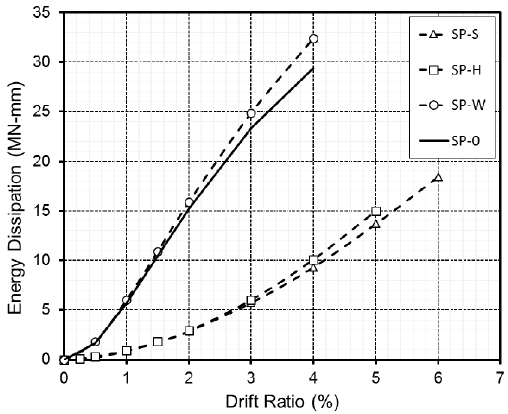
Figure 32. Comparison of energy dissipation.